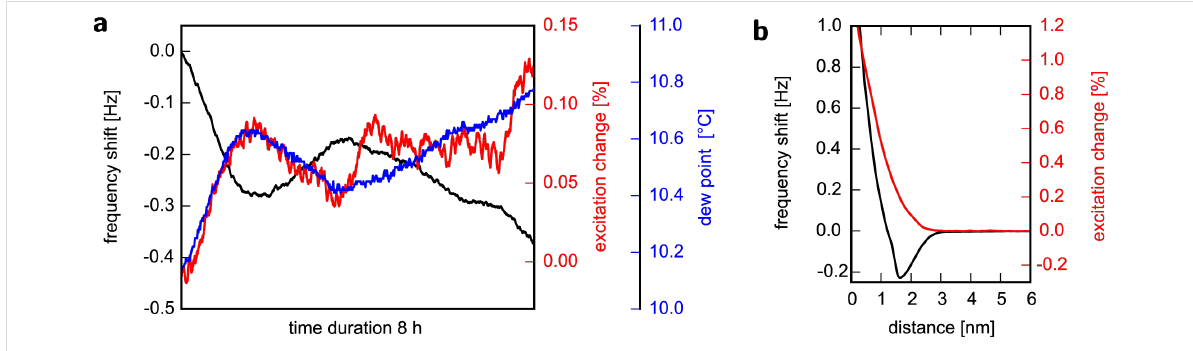
Figure 2: a) Evolution of resonance frequency shift (black), excitation (red), and dew point (blue) over a duration of 8 h. Z-feedback is disabled and the Z-piezo is fully retracted. b) Frequency shift (black) versus distance plot with simultaneously recorded excitation (red) to maintain a constant amplitude of 1.1 nm on a KBr(001) single crystal surface after cleavage in air. The initial excitation is 2.961 mV.